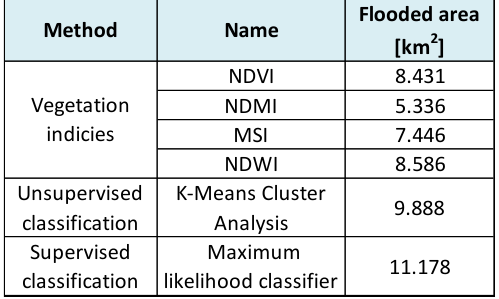
Table 4 . Size of the flooded area obtained by the different methods